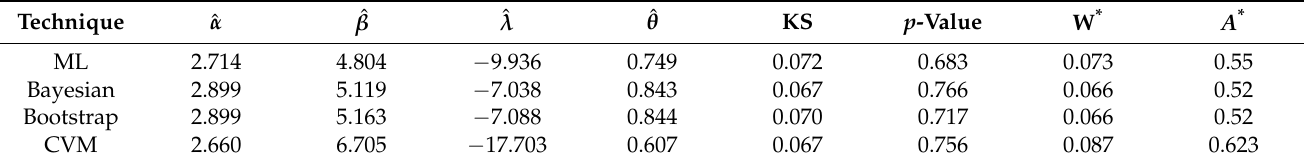
Table 7. The estimated parameters, KS, p -values, W ∗ , and A ∗ for all estimation techniques using the 1st dataset.